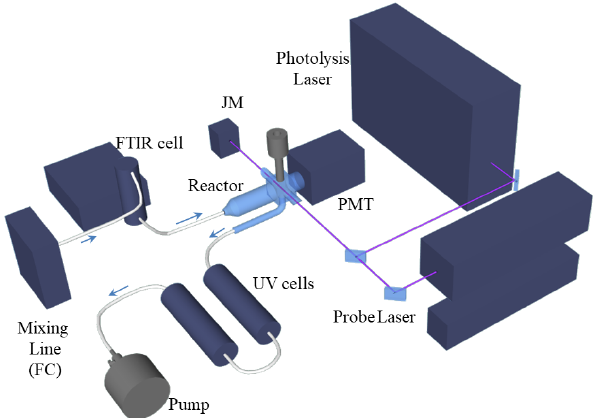
Figure 1. PLP-LIF experimental set-up. PMT is the photomulti- plier, JM the joule meter and FC the flow controller. The IR and UV absorption cells are at room temperature. The photolysis laser is an excimer laser (Compex 205 F, 248nm) and the probe laser a YAG-pumped dye laser (Quantel Brilliant B and Lambda Physik Scanmate, 281.99 and 287.68nm). The arrows indicate the direction of gas